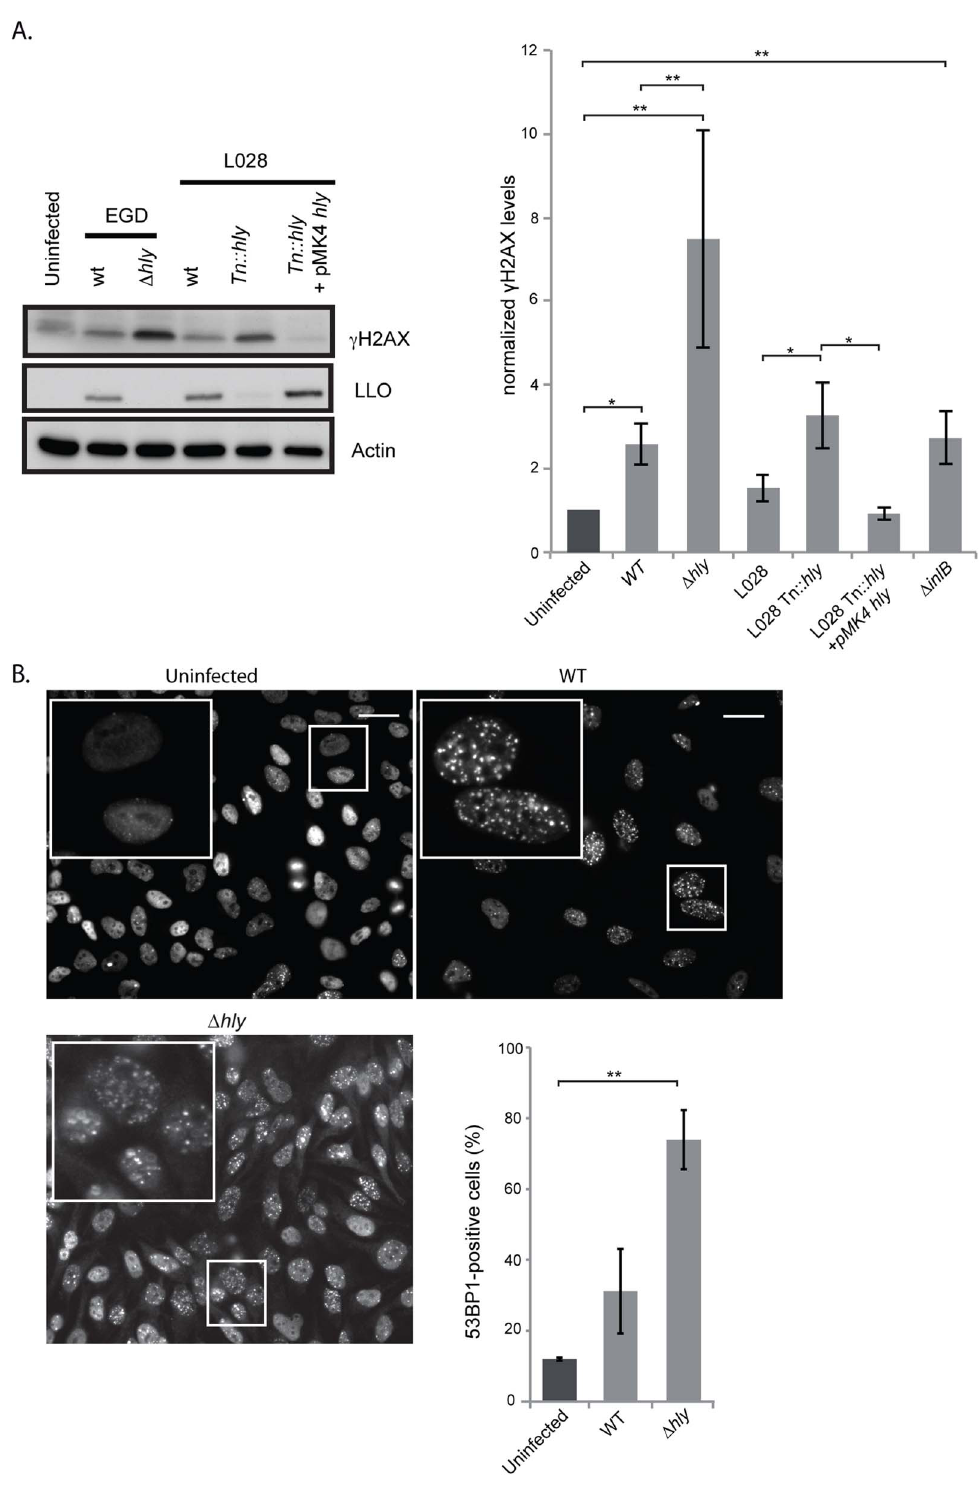
Figure 2. A D hly mutant induces a higher DNA damage response than wild type Listeria . (A) HeLa cells were infected for 24 h with the indicated strains of Listeria . Cell extracts were collected for immunoblot analysis. A representative immunoblot (left) and a quantification (right) of at least 3 independent experiments are shown. The c H2AX levels are normalized to actin and to the uninfected condition. (B) Immunofluorescence of 53BP1 in HeLa cells infected with Listeria for 24 h and quantification of 53BP1-positive cells from at least 3 independent experiments, for a total of more than 500 cells counted. All quantifications in graphs show the mean + / 2 SEM (* indicates p , 0.05, ** p , 0.01). Size bars represent 30 m m, insert is 2.5 times larger than box in original image.